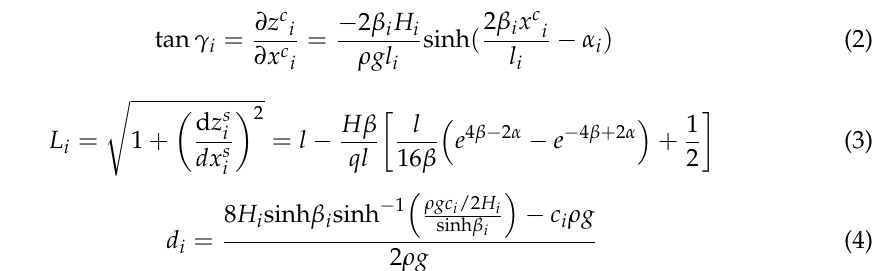
Figure 1. Catenary cable profile. Then, the slope of catenary cable at the terminal point, the catenary cable length, L i , and the corresponding sag, d i , can be obtained according to the following equations,